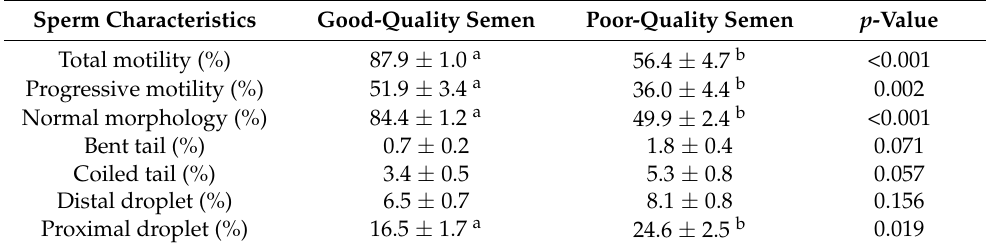
Table 1. Semen characteristics in good-quality and poor-quality boar semen. Sperm